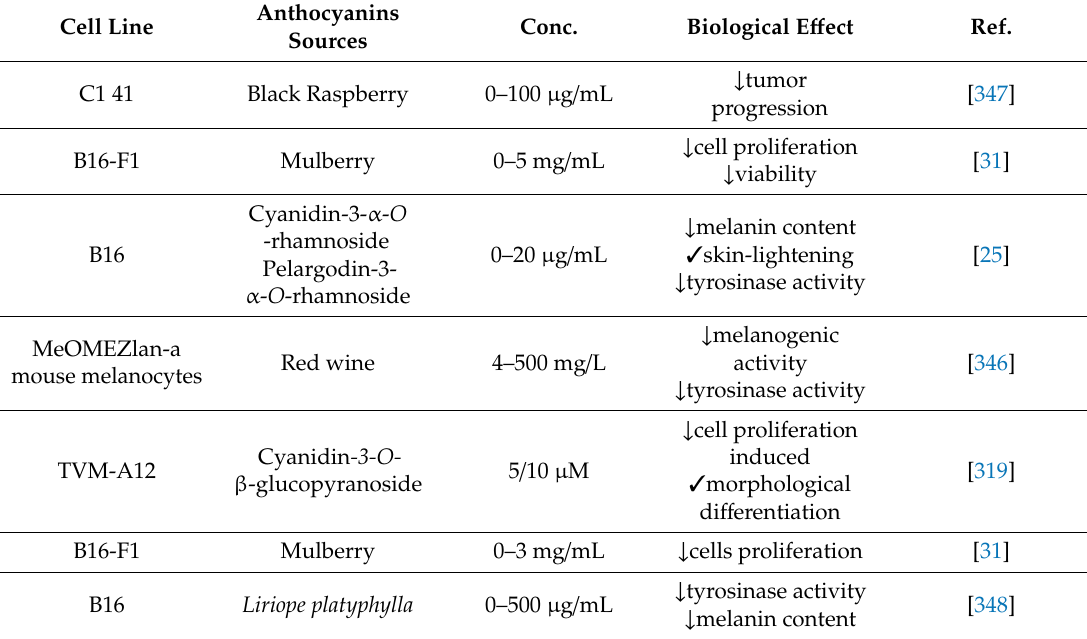
Anthocyanins from di ff erent food matrices and their positive biological e ff ects against melanoma.